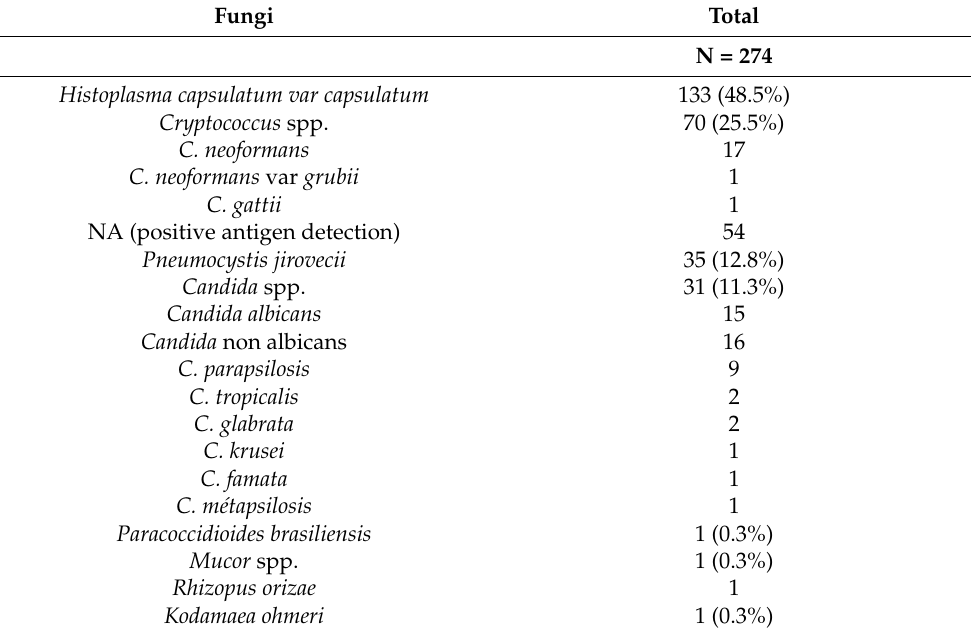
Table 2. Species distribution.